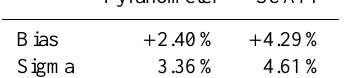
Table 1. Statistics of comparison model-measurement, instrument classes treated separately. The model overestimates for both cate- gories, but di ff erence is larger for SCAPP.